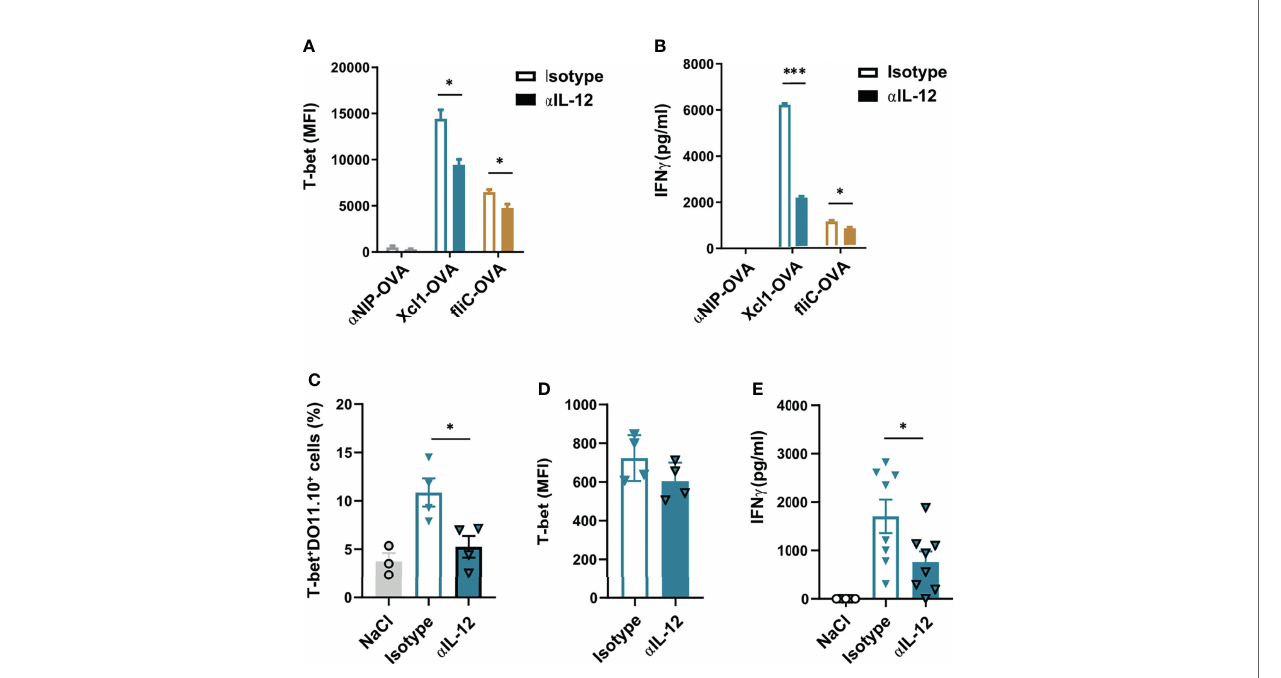
FIGURE 3 | Xcl1-OVA induced Th1 polarization is IL12 dependent. (A, B) CD4 + cells from DO11.10 mice were incubated with BMDCs and Xcl1-OVA, fl iC-OVA, or a NIP-OVA proteins (0.5 m g/ml), and either anti-IL-12 or isotype-matched mAbs (10 m g/ml) for 72 h. (A) DO11.10 cells were evaluated for expression of T-bet by fl ow cytometry, and (B) supernatants tested for secretion of IFN g by ELISA. (C – E) 1 × 10 6 naïve DO11.10 cells were transferred i.v. to BALB/c mice that were subsequently immunized i.d. with 25 m g DNA encoding Xcl1-OVA. On days 1 and 2 after immunization, mice were injected i.p. with anti-IL12 or isotype-matched mAb (0.5 mg). Skin draining LNs and spleens were harvested after 1 week, and LN analyzed for (C) percentage of T-bet + DO11.10 + cells and (D) MFI of T-bet expression in T-bet + DO11.10 + cells. (E) Secretion of IFN g from splenocytes stimulated for 24 h with the DO11.110 peptide. Data representative of two (A – D) or pooled from two (E) independent experiments with n = 3 samples per group (A, B) , n = 3 – 4 mice per group (C, D) or n = 7 – 8 mice per group (E) . Statistical analysis performed using the parametric t-test. *p < 0.05, ***p <